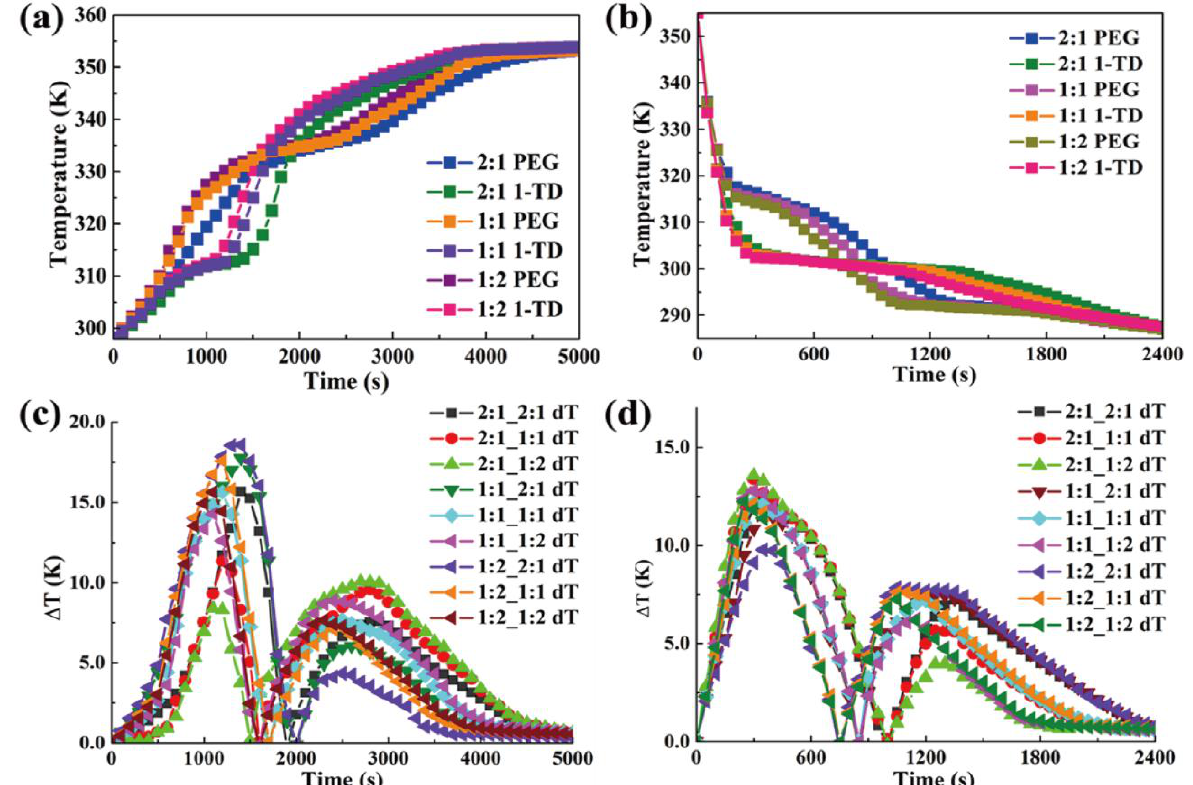
Figure 10. Temperature profiles for PCM composites with different GNP ratios during the ( a ) heating process and ( b ) cooling process. Temperature difference for PCM composite during the ( c ) heating process and ( d ) cooling process.